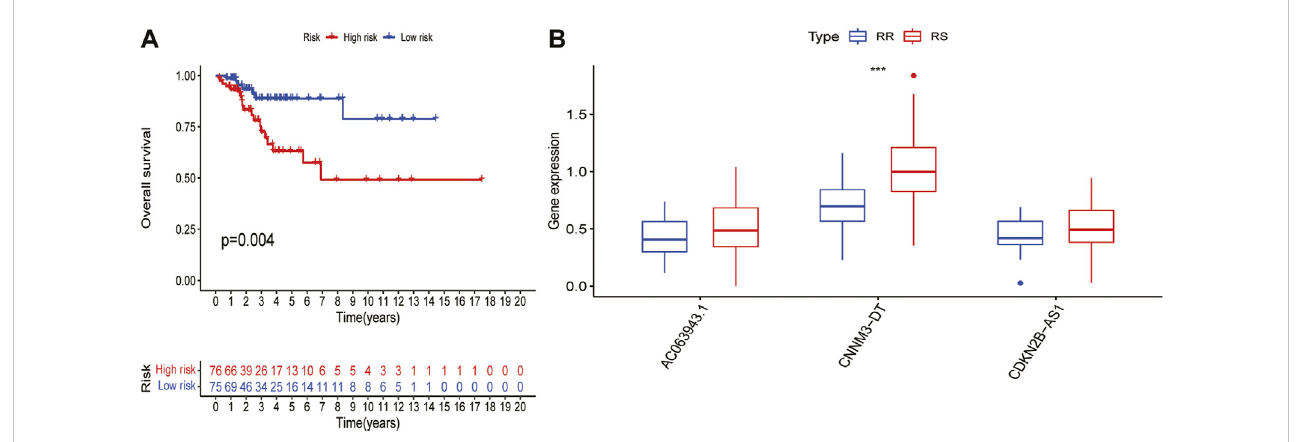
FIGURE 5 Prediction of risk score in patients with cervical cancer undergoing radiotherapy. (A) Differences in OS between HRG - and LRG in patients receiving radiotherapy. (B) Differences in expression of three lncRNAs in the signature between RS and RR groups.